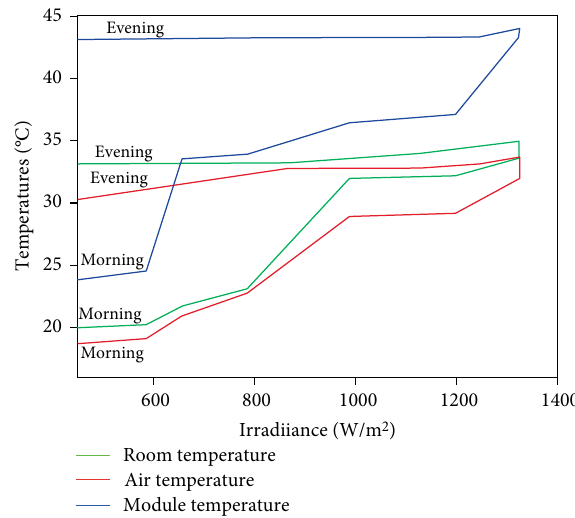
Figure 6: Temperature of the panel ( 𝑇 m ), air inside ( 𝑇 r ), and outside ( 𝑇 a ) of the building versus solar irradiance 𝐺 during the